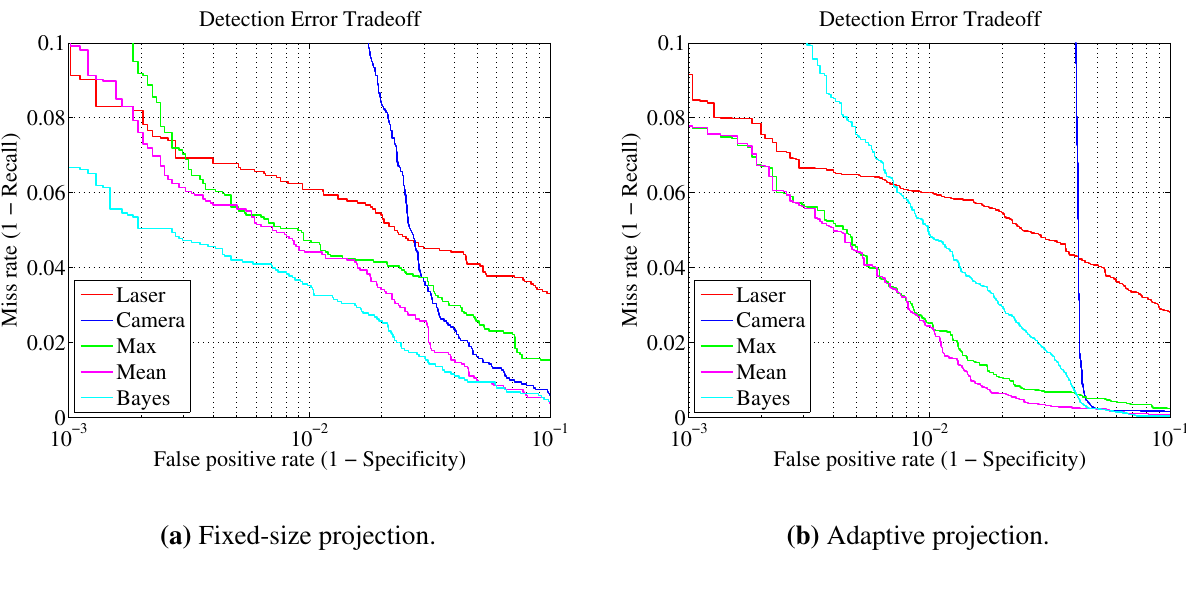
Figure 8. Gymnasium experiment detection error tradeoff curves. The curves are plotted for each sensor individually and, also, for the three fusion techniques. Fixed-size (a) and adaptive (b) projection techniques are compared.